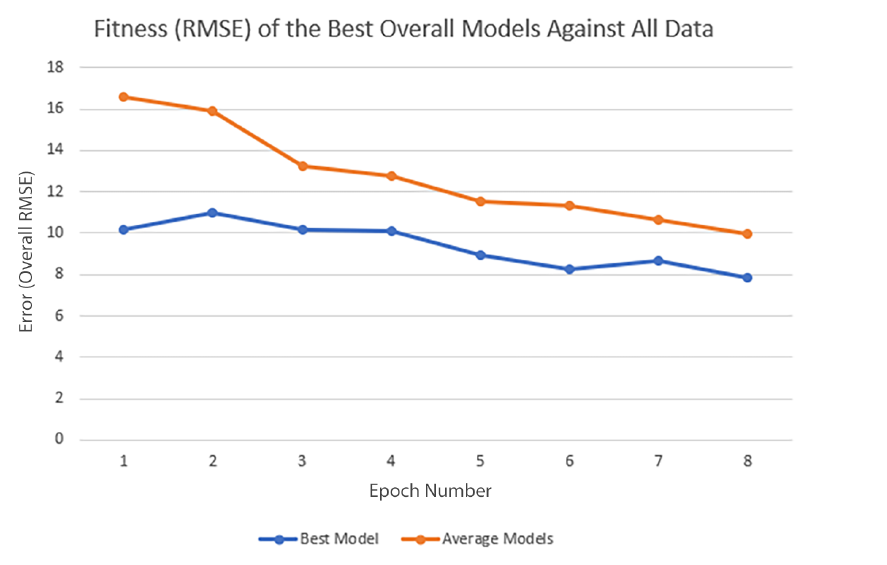
Figure 6 Improvement of the POET models in each epoch of the experiment. Overall RMSE (RMSE over all available data) levels for the best models of each epoch (blue) and the average overall RMSE of all the models in each epoch (orange) are tested against all available data.